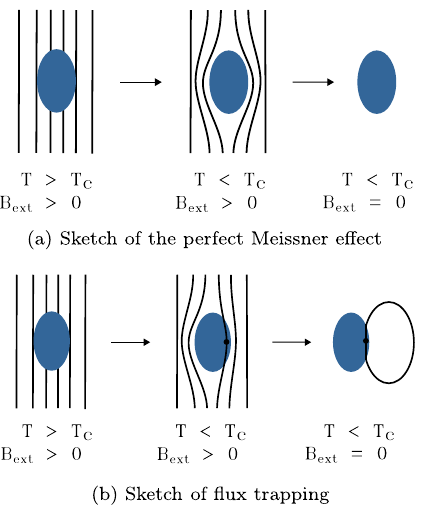
FIG. 1. Comparison between the perfect Meissner effect and the suppression of the flux expulsion due to flux